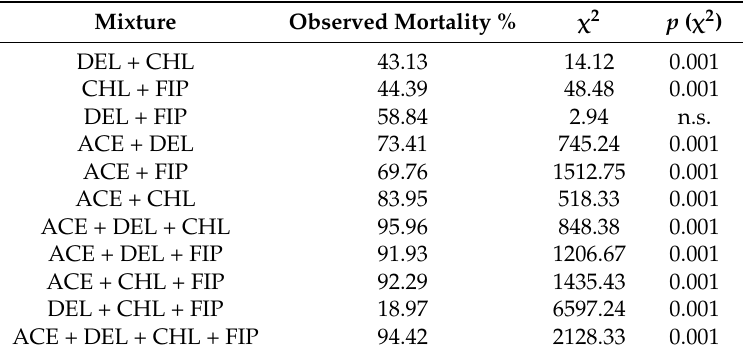
Table 3. Toxicity of the insecticide mixtures after 48 h in the pea aphid A. pisum